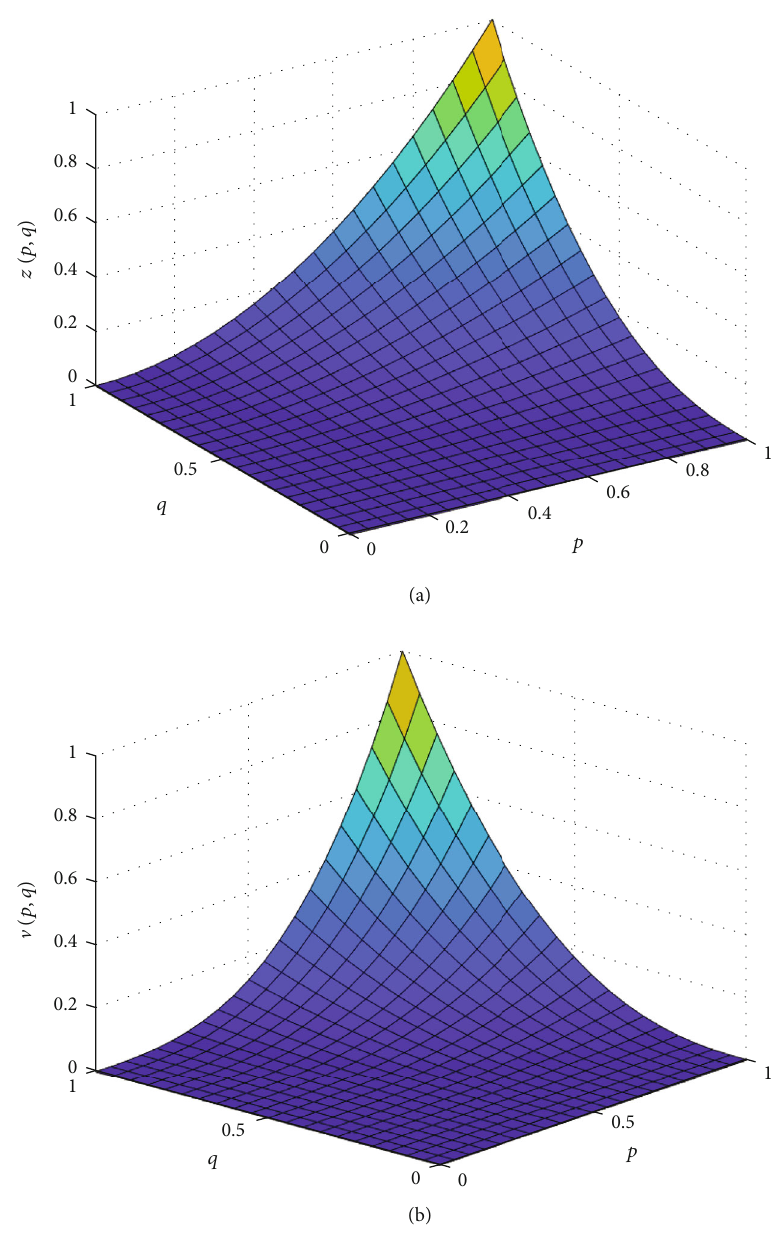
Figure 7: Numerical solution of z ð p , q Þ , v ð p , q Þ with ρ = ω = υ = 1 for Example 10 when m = 6